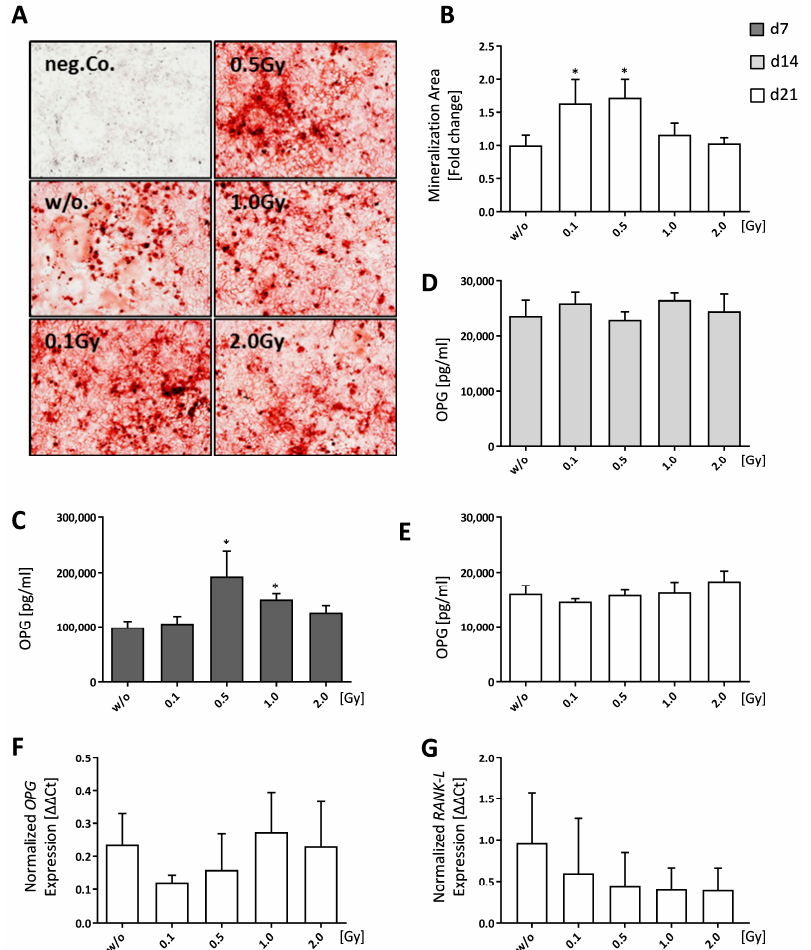
Figure 4. Low doses of ionizing radiation have a positive impact on bone formation of healthy osteoblasts. Pre-osteoblasts were isolated from the calvariae of 3–6 days old neonatal mice and seeded at P2. Cells were allowed to grow until 80–90% confluency before mineralization medium (PromoCell) was added. Irradiation was carried out 24 h after addition of mineralization medium. After 21 days, bone nodules were stained using alizarin red and mineralization area was calculated using ImageJ. ( A ) Shows exemplary alizarin red images taken at 5× magnification. ( B ) Shows mineralization area as assessed using ImageJ. ( C – E ) display secreted OPG levels as determined via ELISA and ( F , G ) show quantitative PCR (qPCR) data after phenol-chloroform RNA extraction with subsequent gene expression analysis via SYBR green qPCR analyses using housekeepers B2M , ACTB , TBP , and HMBS for normalization. Depicted is joint data from two independently performed experiments with three independently generated osteoblast lines, each performed in triplicates. For qPCR analyses cell lysates from triplicates were pooled. Data is presented as mean ± SEM and analysed by two-tailed Mann-Whitney-U test in comparison to untreated controls (* p < 0.05).